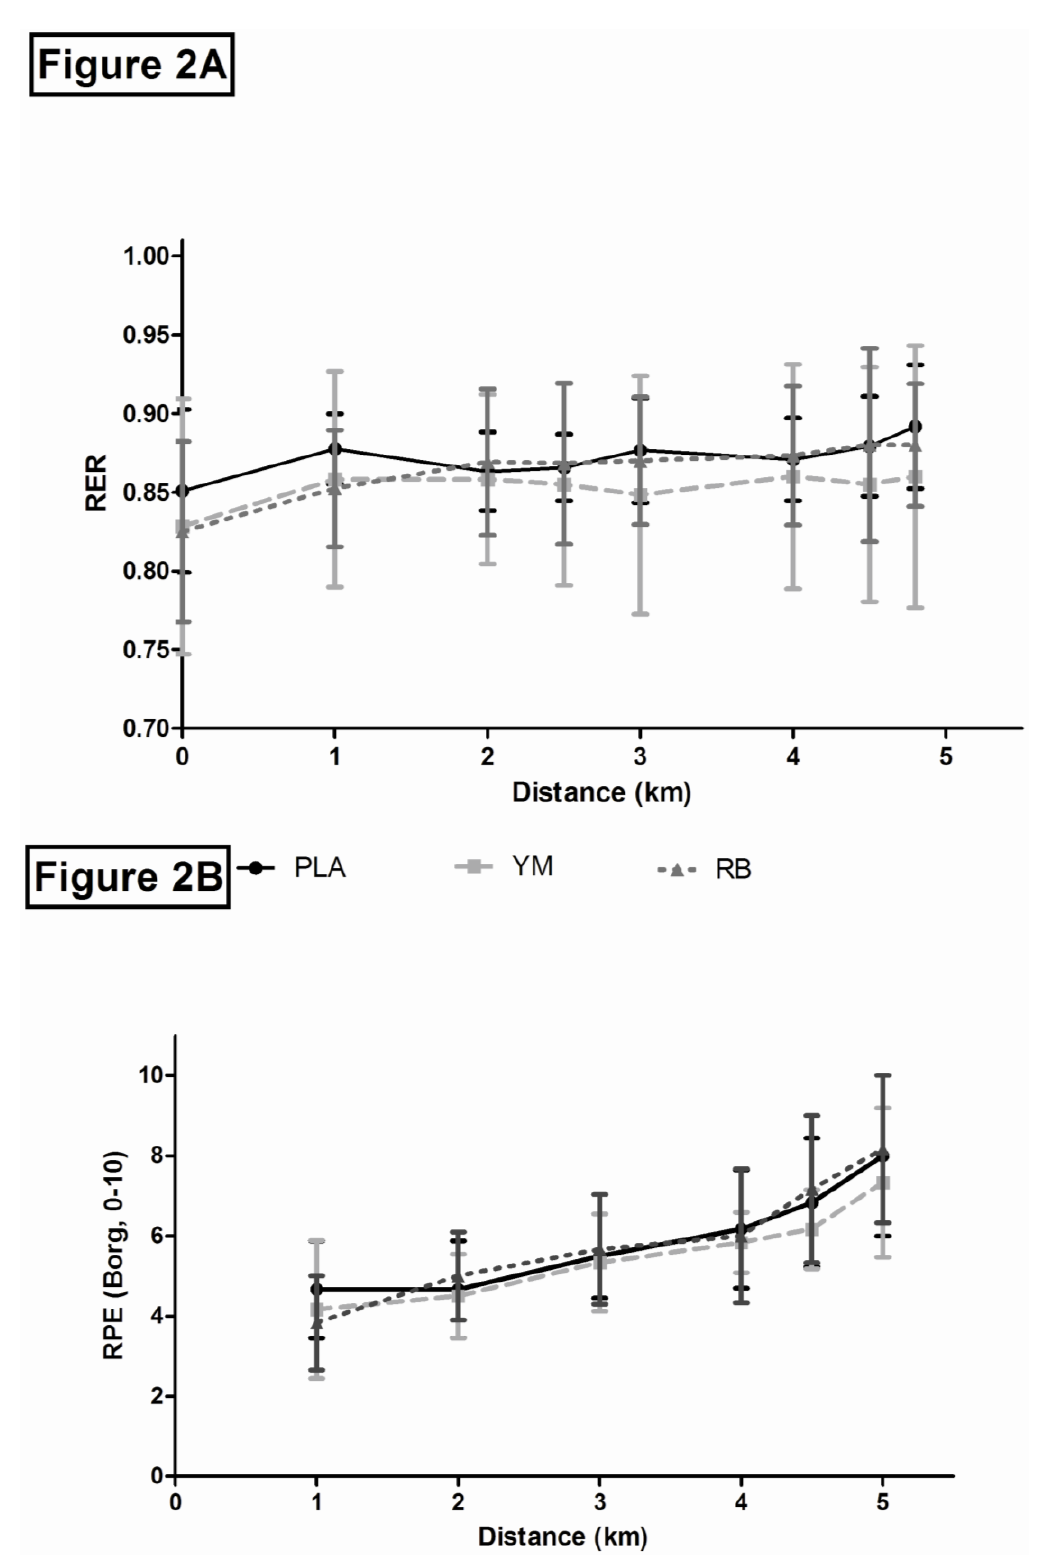
Figure 2. A Respiratory exchange ratio (RER) mean ± SD in response to ingestion of RB, YM, or PLA during TT. PLA = solid black line with squares (■); YM = dotted light grey line with triangles (▲); RB = dashed dark grey line with circles (●). Figure 2B: RPE mean ± SD in response to ingestion of RB, YM, or PLA during TT. PLA = solid black line with squares (■); YM = dotted light grey line with triangles (▲); RB = dashed dark grey line with circles